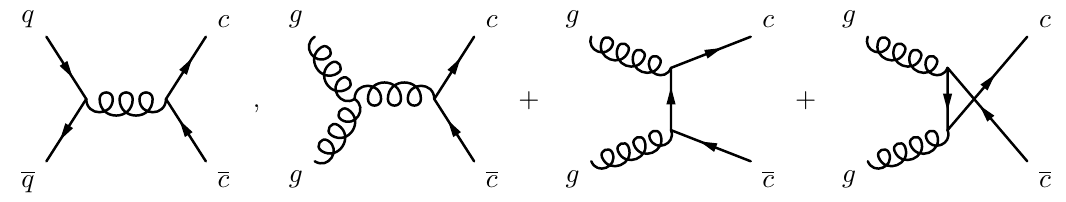
Figure 10 . These are the four diagrams contributing to the hard process in open charm production. The diagrams with gluons in the initial state interfere with each other giving rise to cross terms in the colour